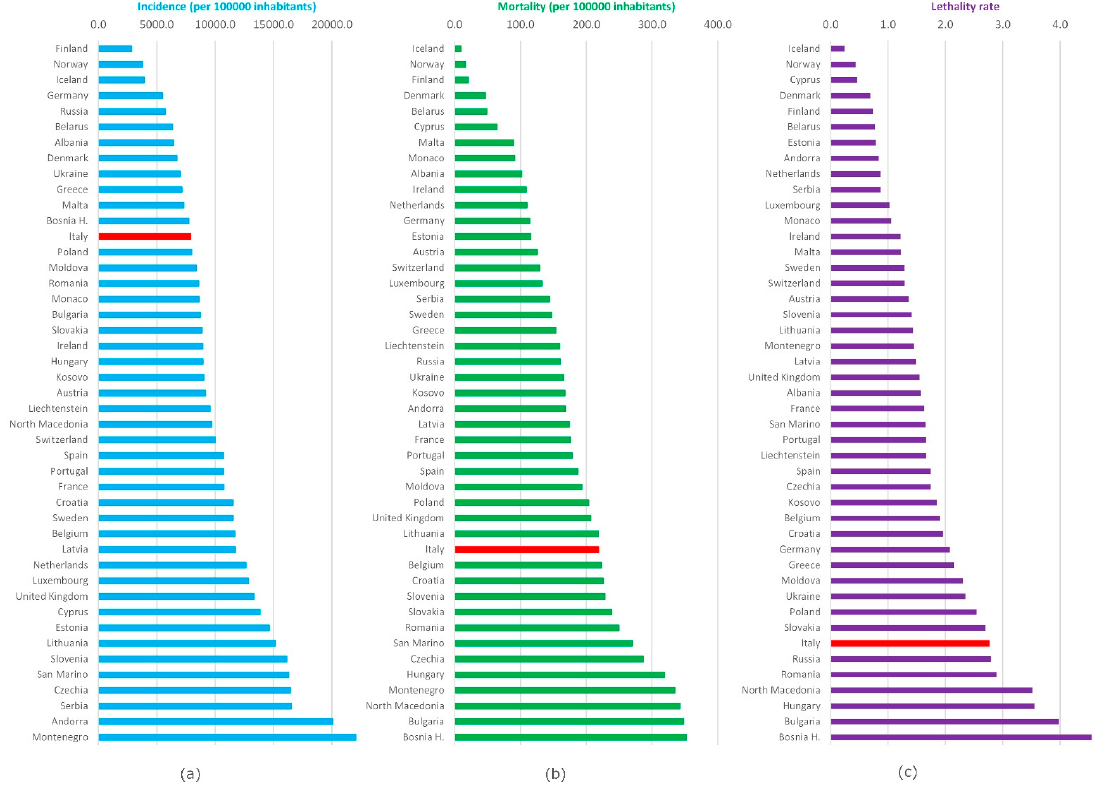
Figure 5. Comparison among European countries: ( a ) Incidence, ( b ) mortality, ( c ) lethality. For European countries, the resident population reported by the Our World in Data was used.